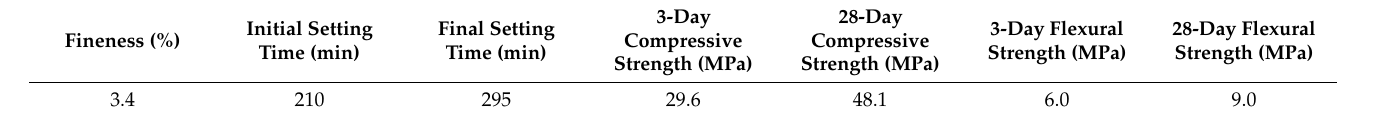
Table 3. Basic physical and mechanical indexes of P.O42.5 cement.